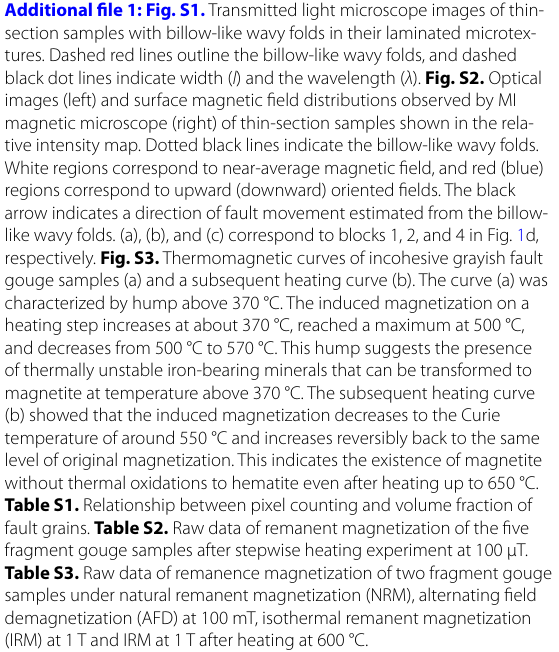
Table S1. Relationship between pixel counting and volume fraction of fault grains. Table S2. Raw data of remanent magnetization of the five fragment gouge samples after stepwise heating experiment at 100 μT. Table S3. Raw data of remanence magnetization of two fragment gouge samples under natural remanent magnetization (NRM), alternating field demagnetization (AFD) at 100 mT, isothermal remanent magnetization (IRM) at 1 T and IRM at 1 T after heating at 600